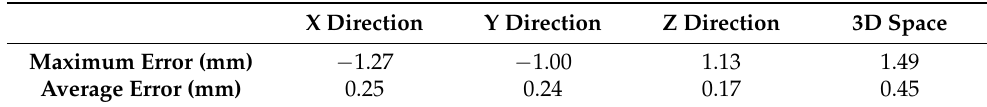
Table 4. Master – slave following errors. Table 4. Master–slave following